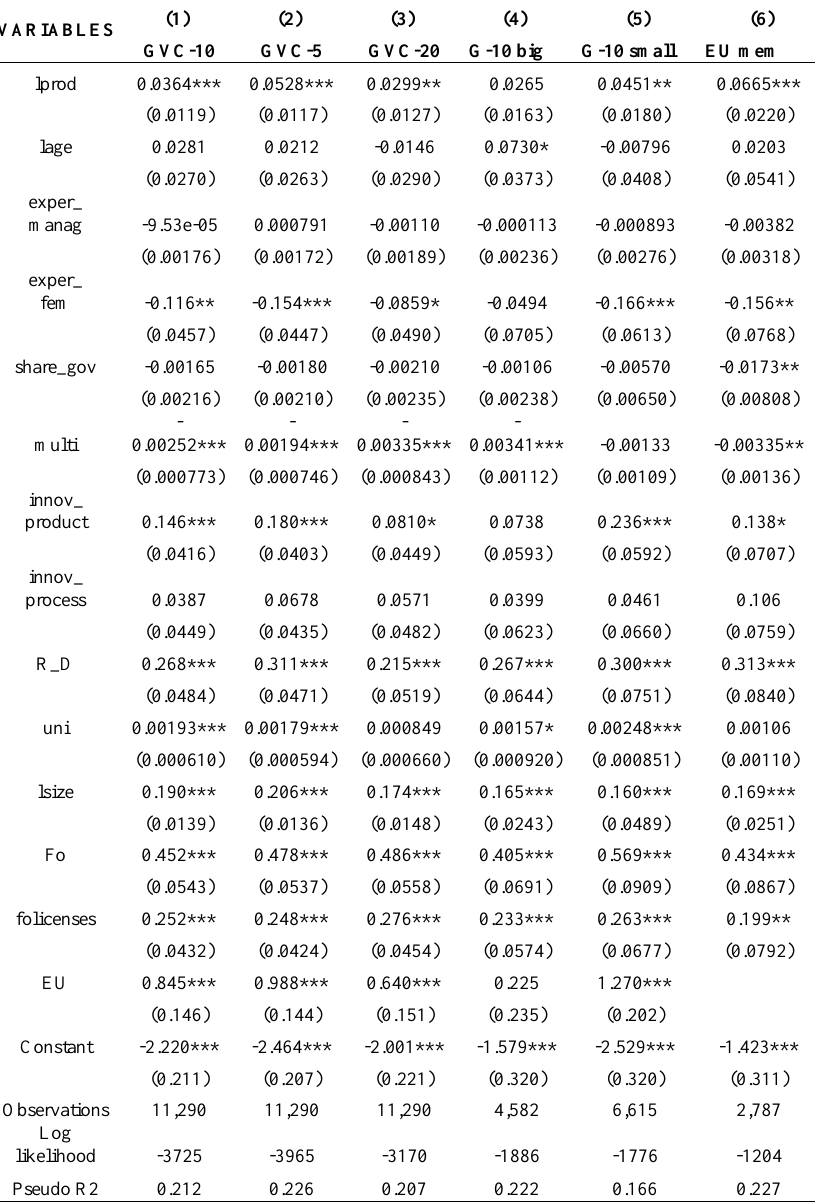
Table 5. Estimation